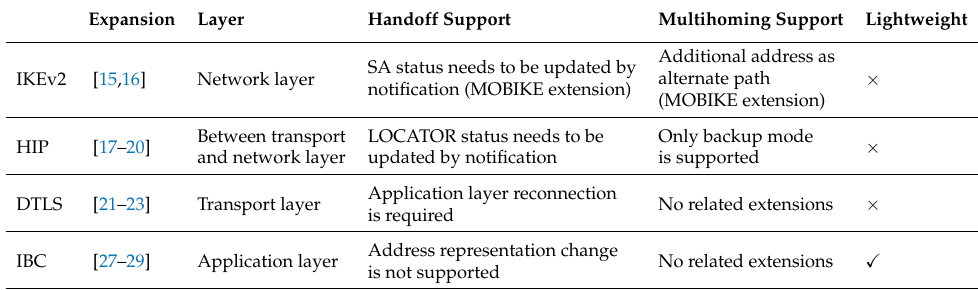
Table 1. Comparison of existing studies.